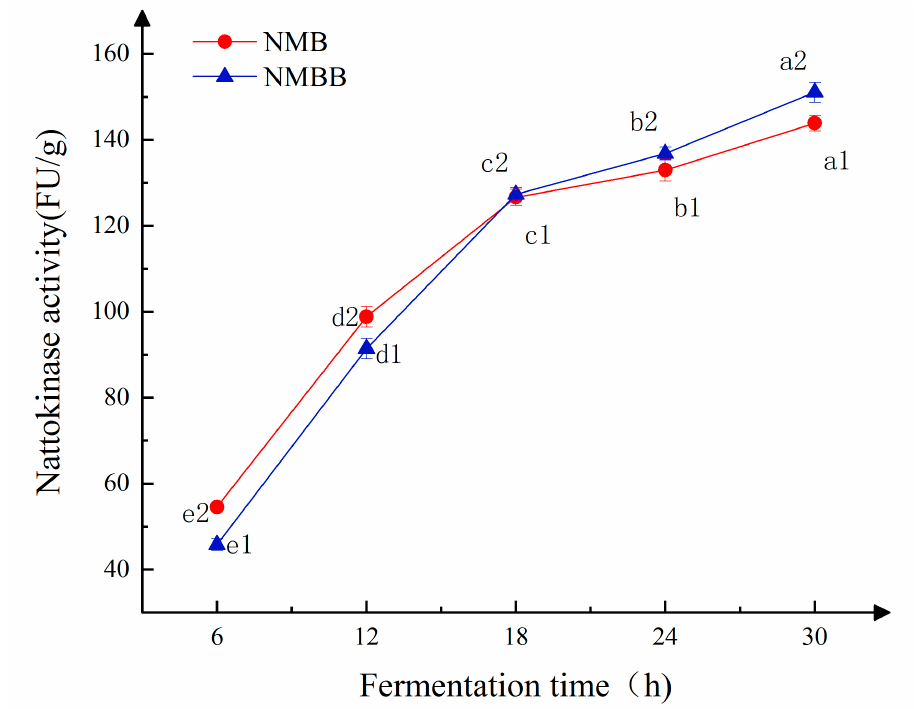
Figure 4. Changes in NK activity during single-strain fermentation and mixed-strain fermentation. Means with dissimilar characters (ai–ei, i = 1 or 2) in the same curve indicate significant differences ( p < 0.05).